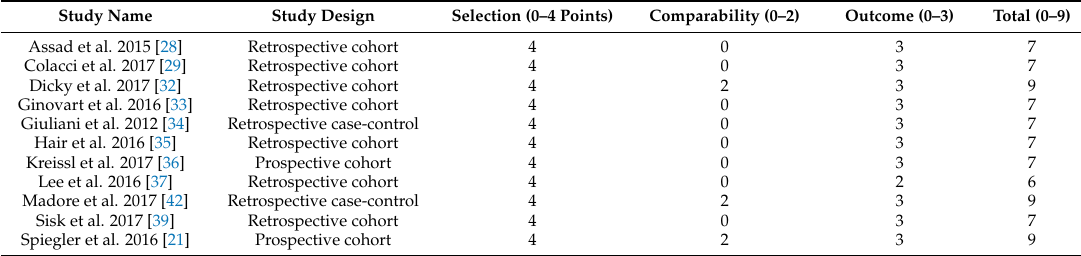
Table A2. Assessment of methodological quality of included observational studies, using the Newcastle-Ottawa